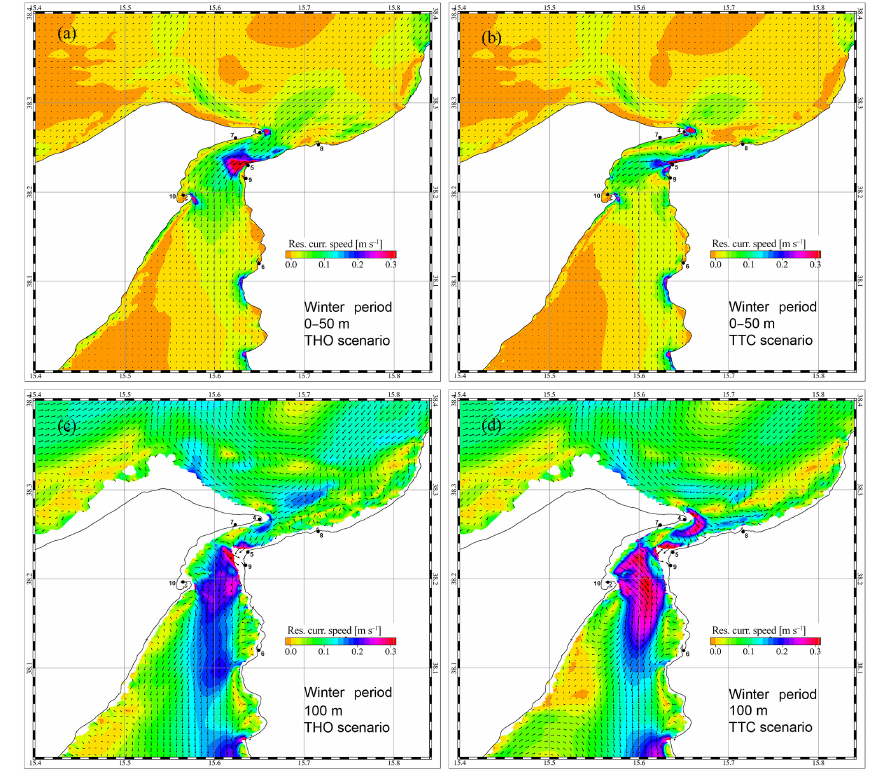
Figure 4. Computed winter residual current field from the THO scenarios results ( a and c ) and from the TTC scenario results ( b and d ). Upper panels refer to average residual velocities computed between 0 and 50m ( a and b ). Bottom panels refer to residual velocities at 100m depth ( c and d